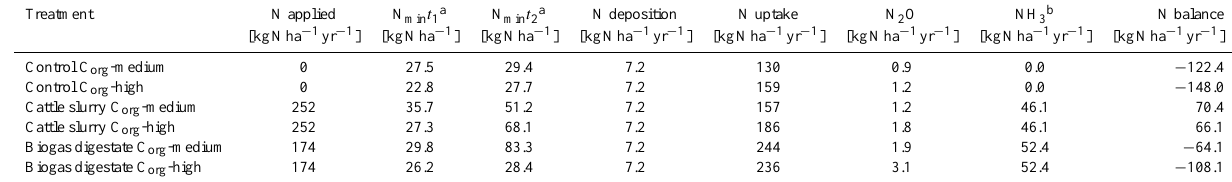
Table 7. Estimated nitrogen balance for the year 2011.